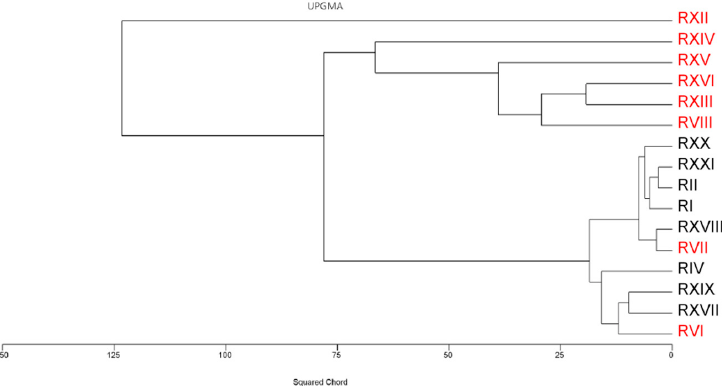
Figure 5. Dendrogram of faunistic similarities for Cladocera fauna in the studied sediment cores (black color: Cores from pond, created after mine was closed (UP); red color: Cores from ponds existed during mine exploitation